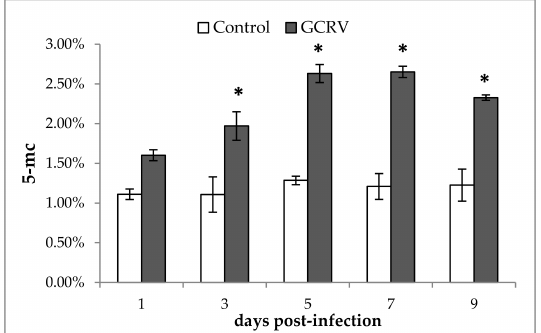
Figure 2. Global DNA methylation level of grass carp after GCRV infection. The spleen samples of two groups at different time points were obtained and global DNA methylation level was analyzed. Data were shown as the mean ± standard deviation of three replicates ( n = 5 for each biological duplicate). Significant difference ( p < 0.05) in DNA methylation level between the two groups are indicated with an asterisk